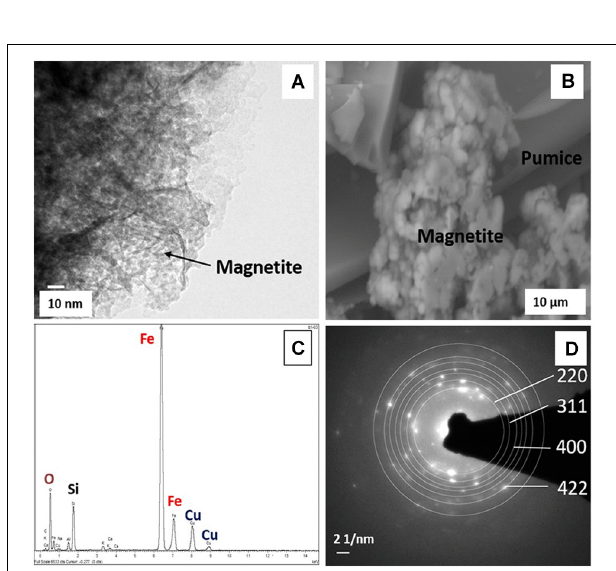
FIGURE 6 | (A) TEM and (B) ESEM micrographs, (C) EDS spectrum, and (D) SAED patterns of biogenic magnetite obtained from the deployed Fe(III)-coated pumice slurries amended with lactate and acetate, incubated for 8 weeks at 20 ◦